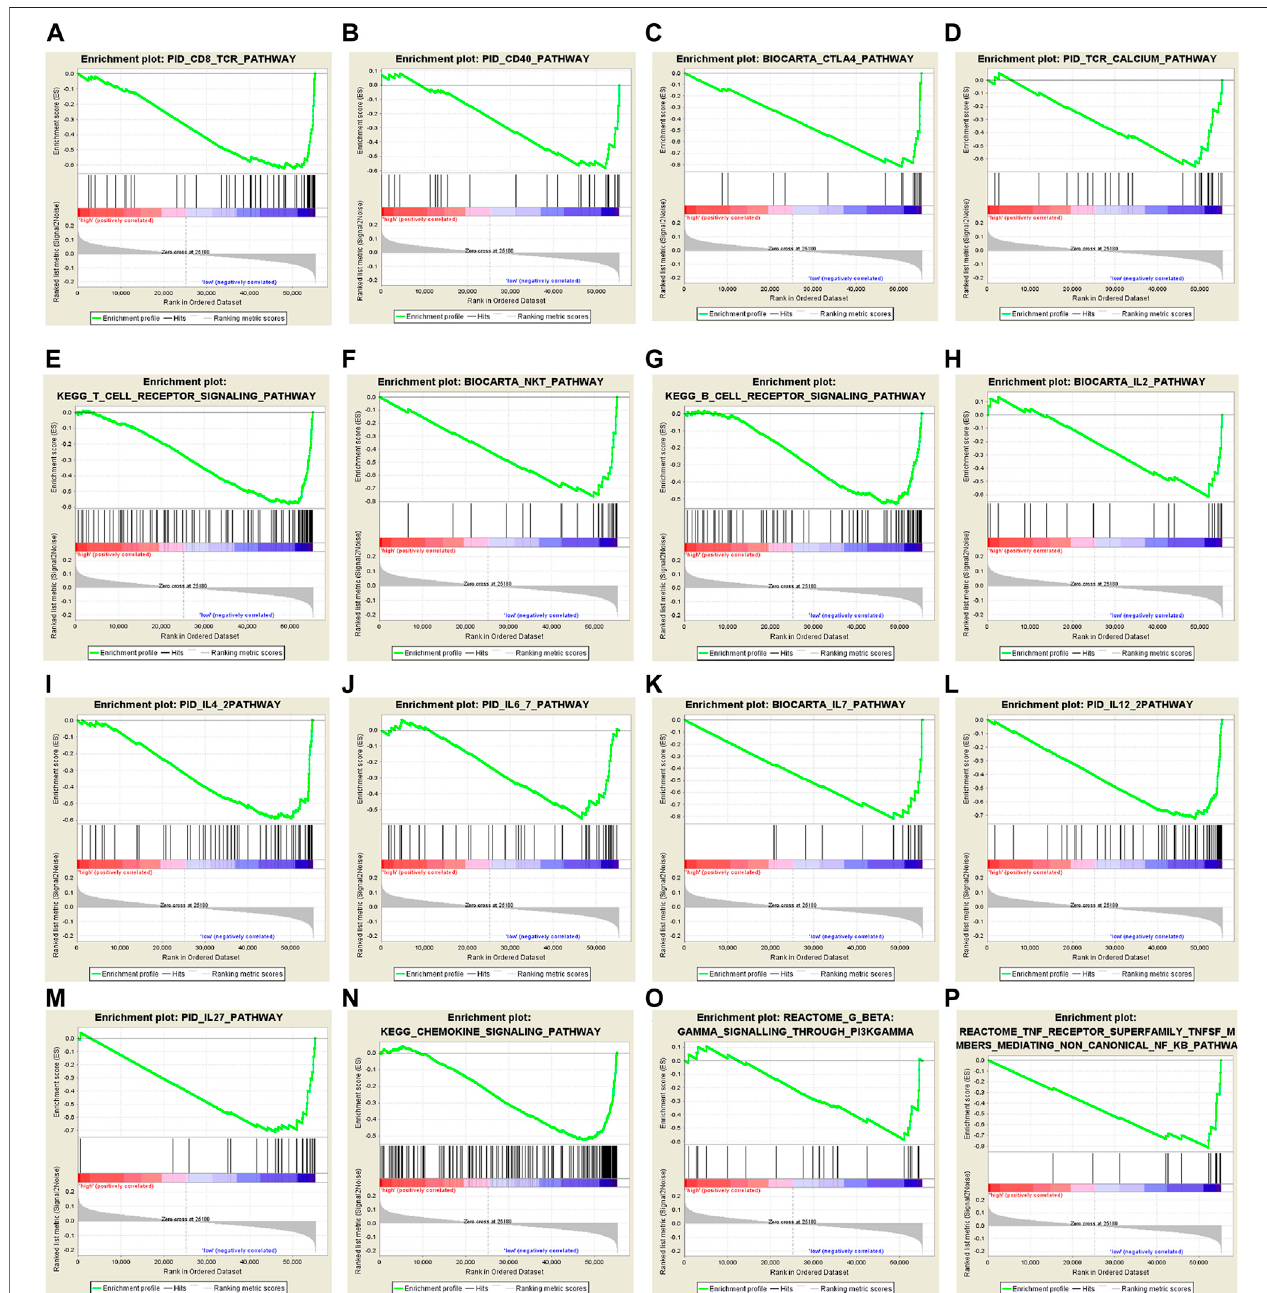
FIGURE 6 | Gene set enrichment analysis (GSEA) delineates the signi fi cantly enriched pathways which are negatively correlated with 10 - CpG-based signature using the “ c2.cp.v7.0. symbols ” gene set, downloaded from the MSigDB database, as the reference. And the signi fi cance threshold was set at nominal p -value < 0.05 and FDR <